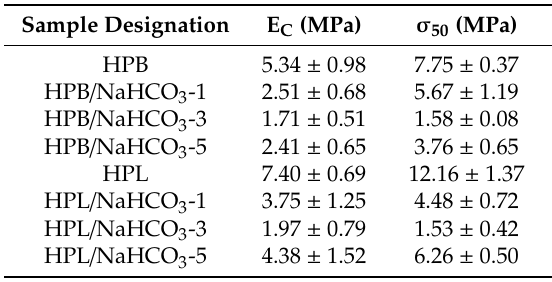
Figure 7. Representative compressive stress–strain curves for the formulations comprising ( a ) hydrophobic (HPB) and ( b ) hydrophilic thermoplastic polyurethane (HPL) with and without NaHCO 3 as the pore former. The confidence interval for a significance level of 5% for the compressive stress at 50% compressive strain ( σ 50 ) is marked by error bars. Table 3. The mean and confidence interval for a significance level of 5% for the compression modulus (E C ) and compressive stress at 50% compressive strain ( σ 50 ) for all investigated formulations comprising hydrophobic (HPB) and hydrophilic (HPL) thermoplastic polyurethanes.